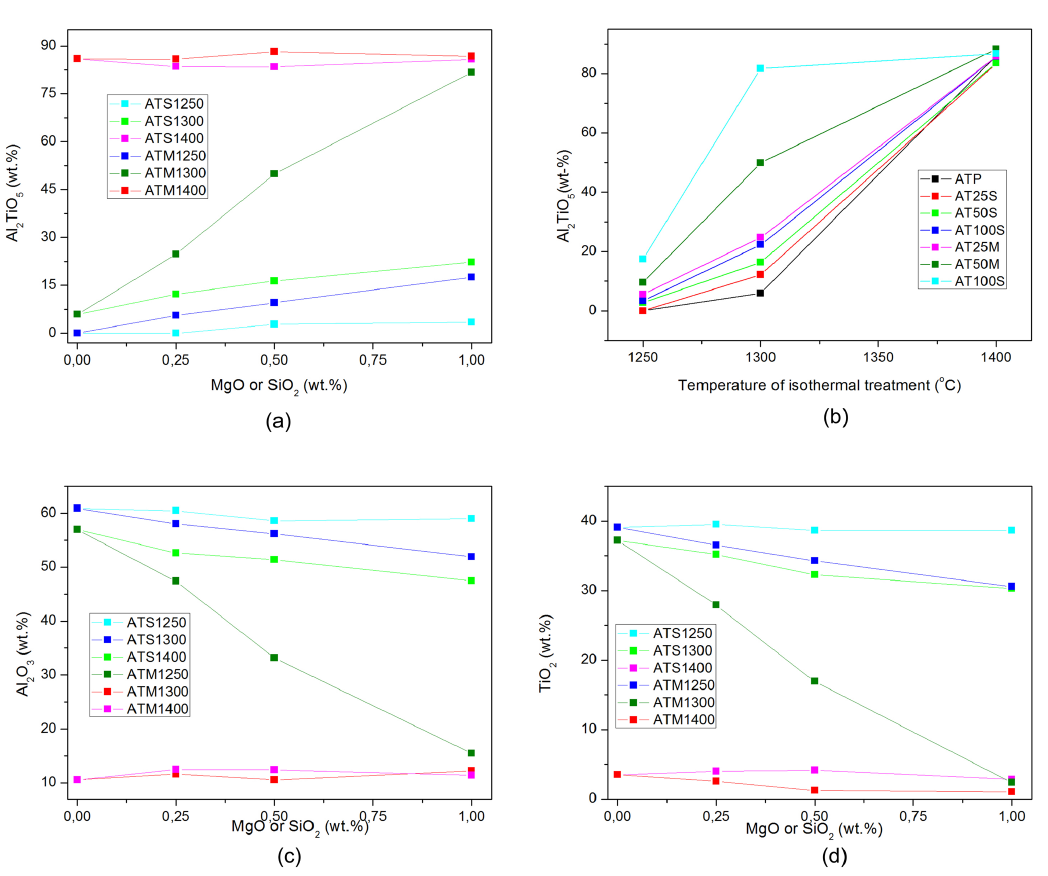
Figure 3. Al TiO (a and b), Al O (c) and TiO (d) contents calculated by the Rietveld method as a function of the additive content and 2 5 2 3 2 heat treatment temperature. ATS is the abbreviation for SiO doped samples; ATM is the abbreviation for MgO doped samples; 1250, 2 1300 and 1400 are the heat treatment temperatures ( o